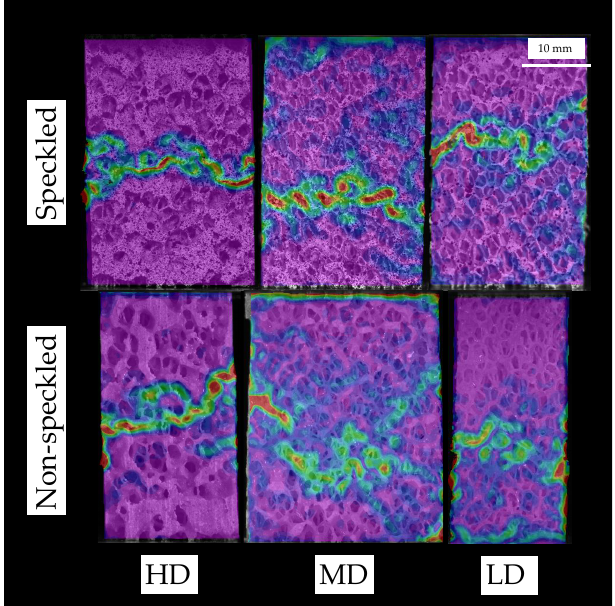
Figure 15. Equivalent strain distribution for speckled and non-speckled specimens. Slight differences are found in failure pattern determination. The failure region is more spread in the non-speckle than in the speckle